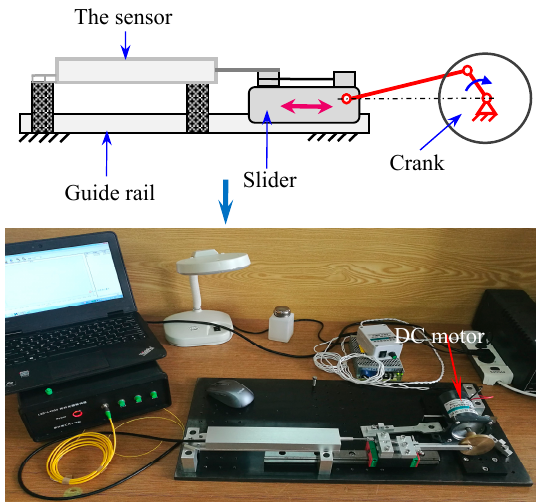
Figure 11. Principle and photo of the experimental equipment for alternating displacement test.